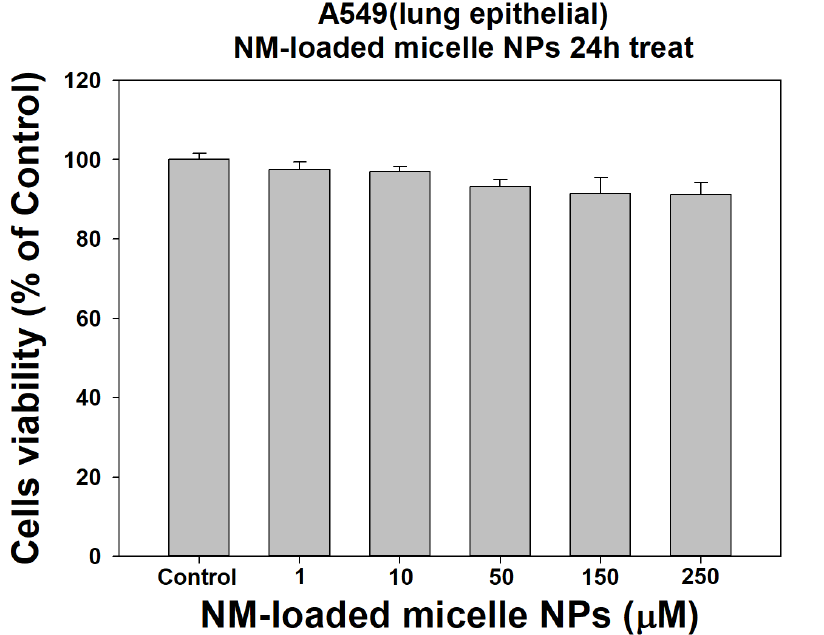
Figure 6. Cytotoxicity of control and NM-loaded micelle NPs (1, 10, 50, 150, and 250 µ M) against A549 cells at one day ( n =